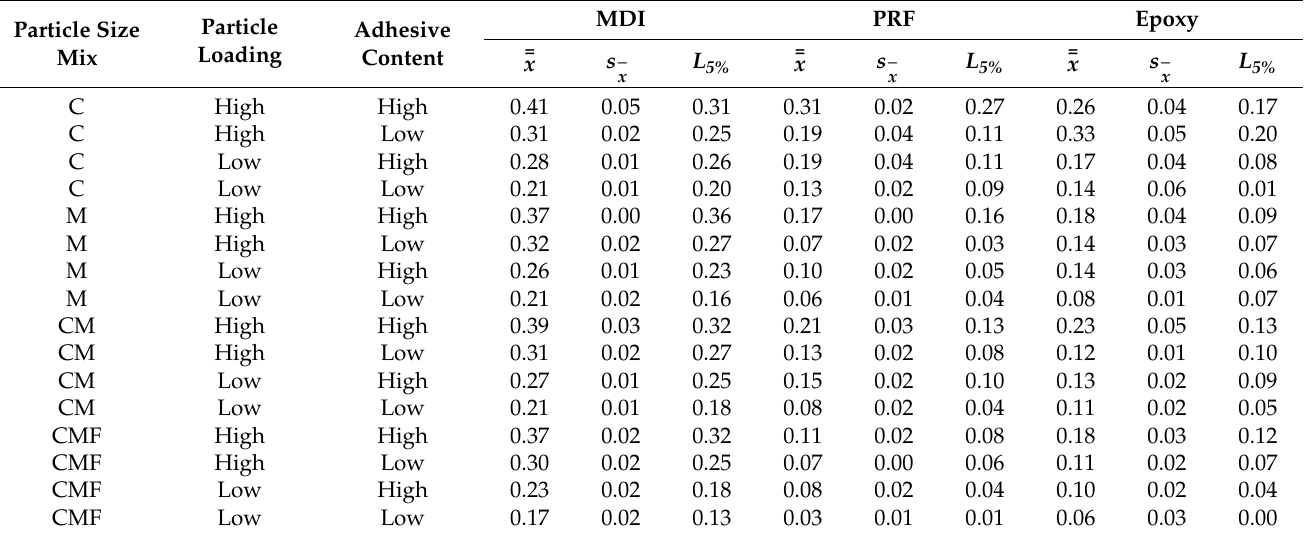
Table 9. IB results and corresponding 5-percentile comparison values of MDI, PRF and epoxy ULHPB.